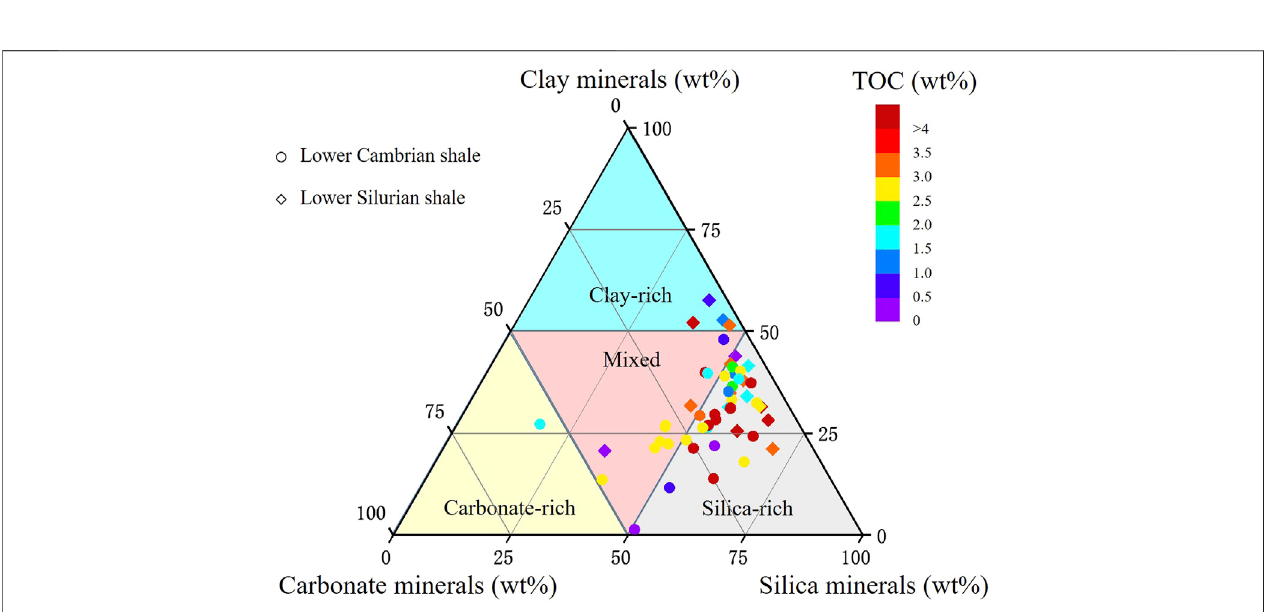
FIGURE 3 | Mineralogical ternary plot: the Lower Cambrian shales are represented by circles, the Lower Silurian shales are represented by diamonds, and TOCs are represented by a color bar.